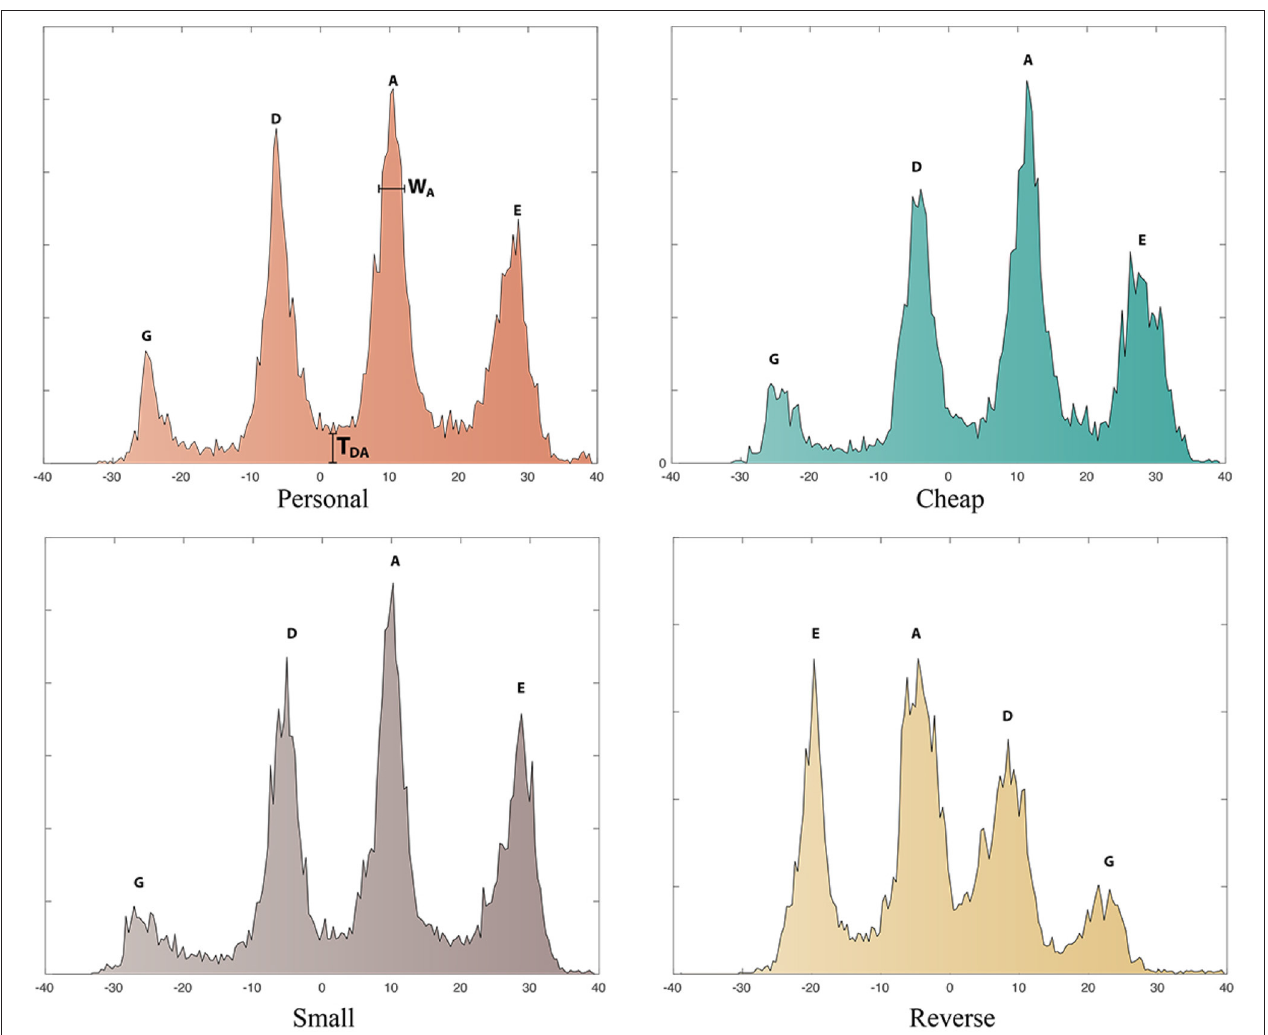
FIGURE 8 | Histogram of the bow angles relative to a single performance played with the personal (Top left) , cheap (Top right) , small (Bottom left) , and reverse (Bottom right) violin by P3 . G,D,A,E indicate the position of each string; T DA indicates the trough between the strings D and A; W A indicates the width of the peak relative to the A